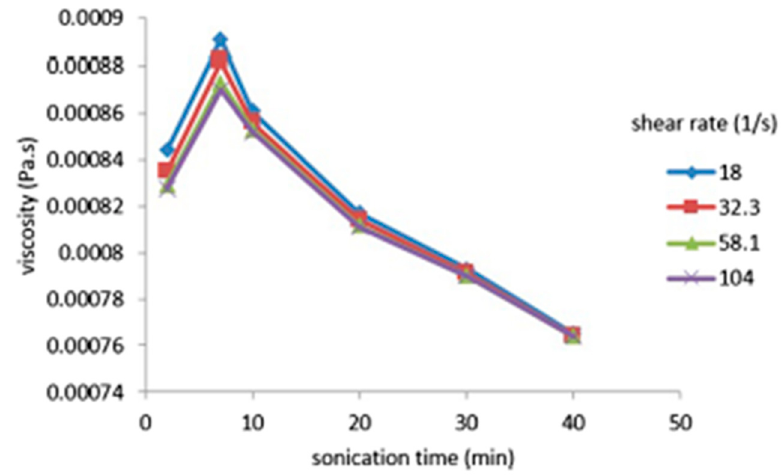
Figure 6. Variation in dynamic viscosity as function of sonication time at various shear rates at 45 °C [126].